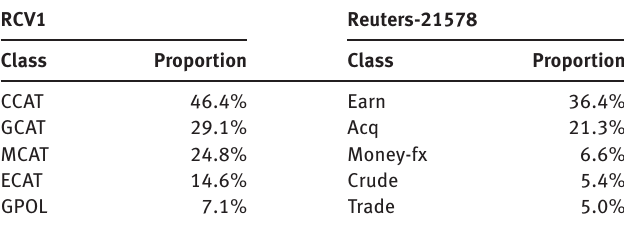
Table 1: Class Label Proportion for the Top 5 Classes in RCV1 (Left) and Reuters-21578 (Right). RCV1